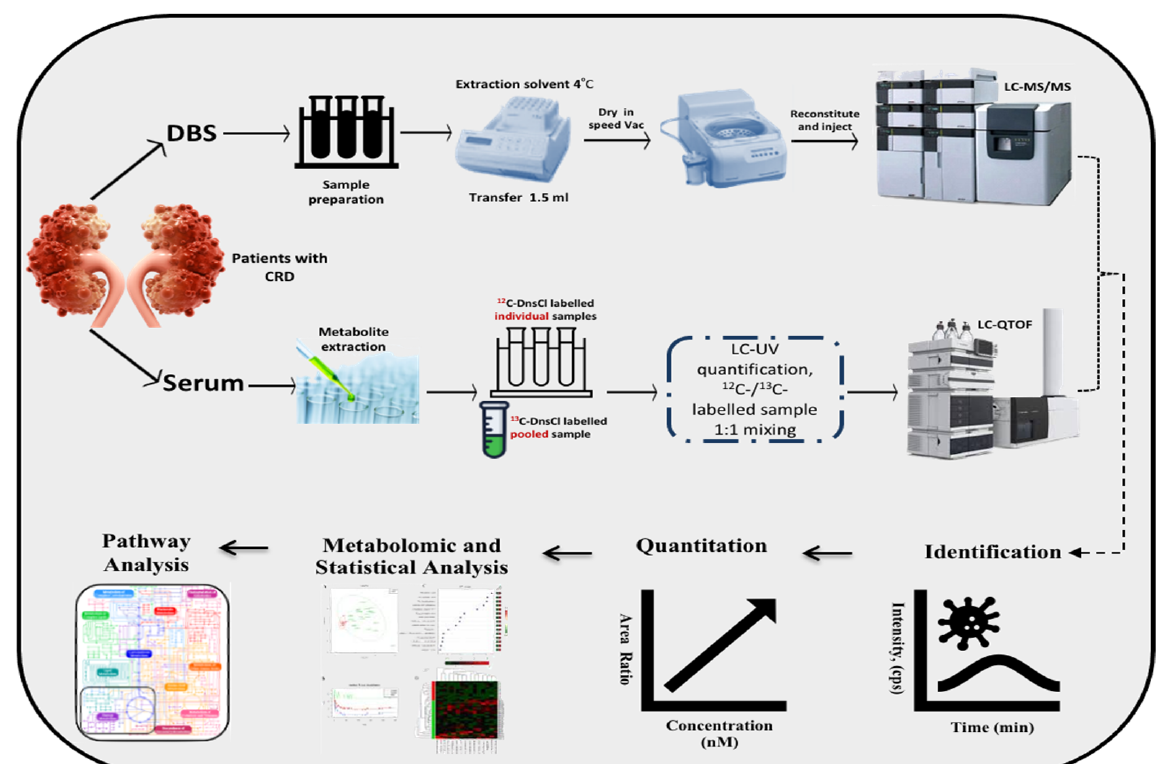
Figure 1. Metabolomics workflow.